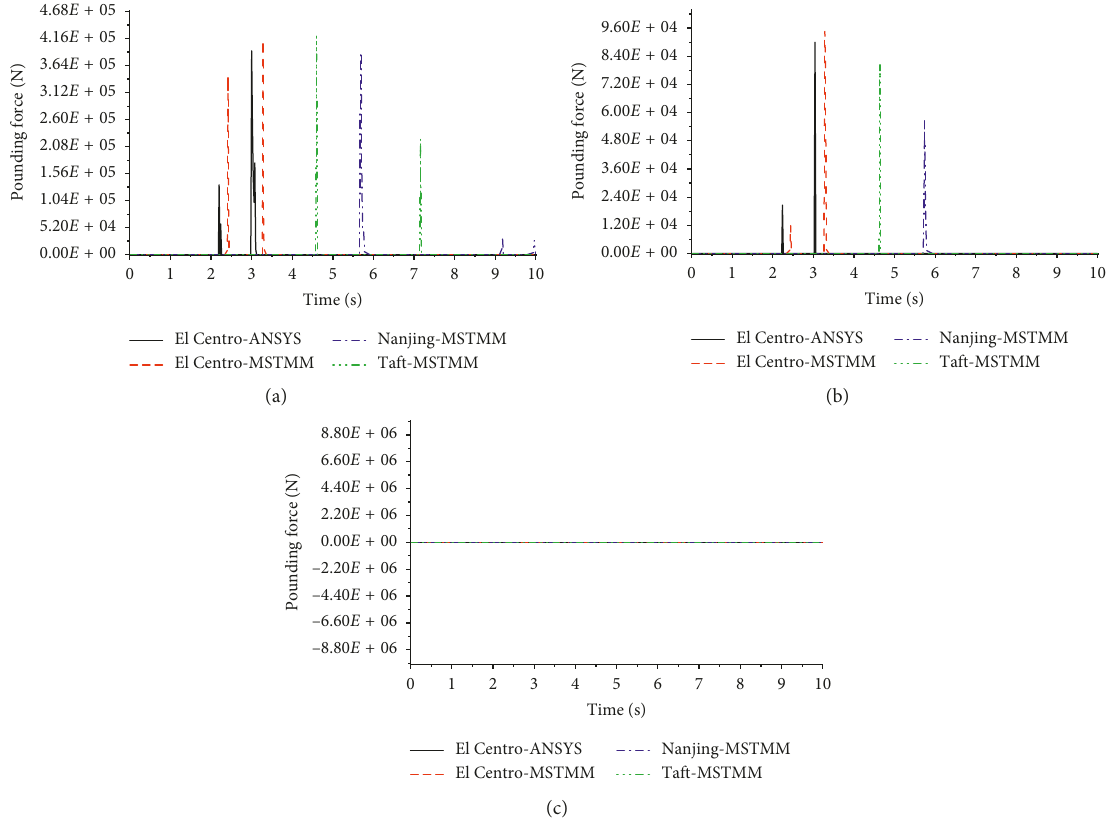
Figure 13: Time-history diagram of J (b) 130mm, and (c) 150